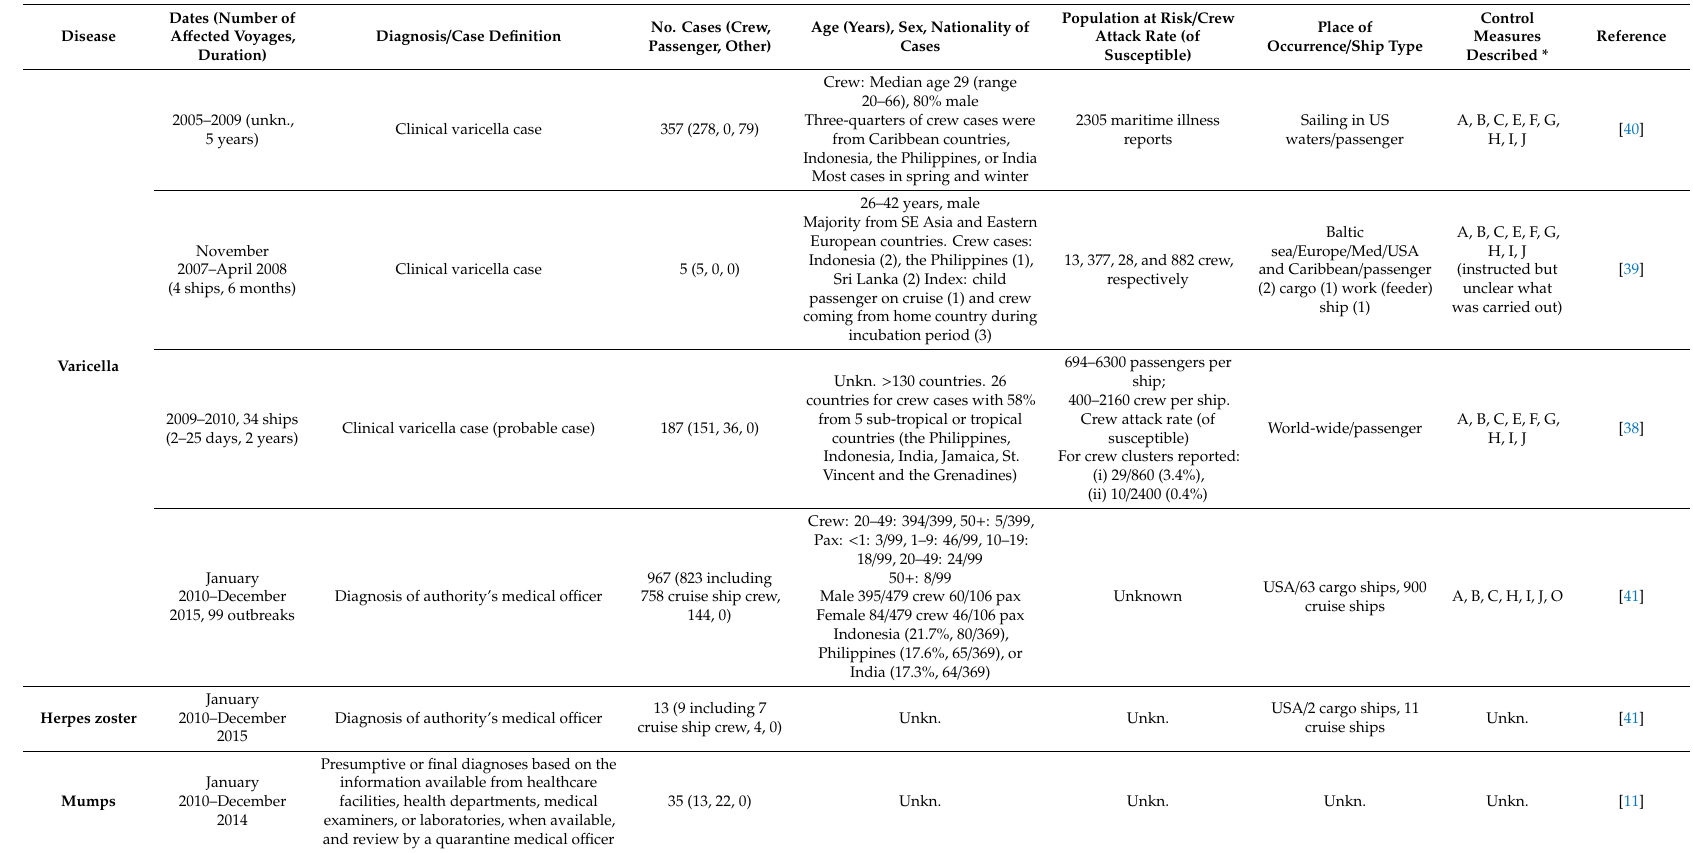
Table 2. Vaccine-preventable diseases identified through record review